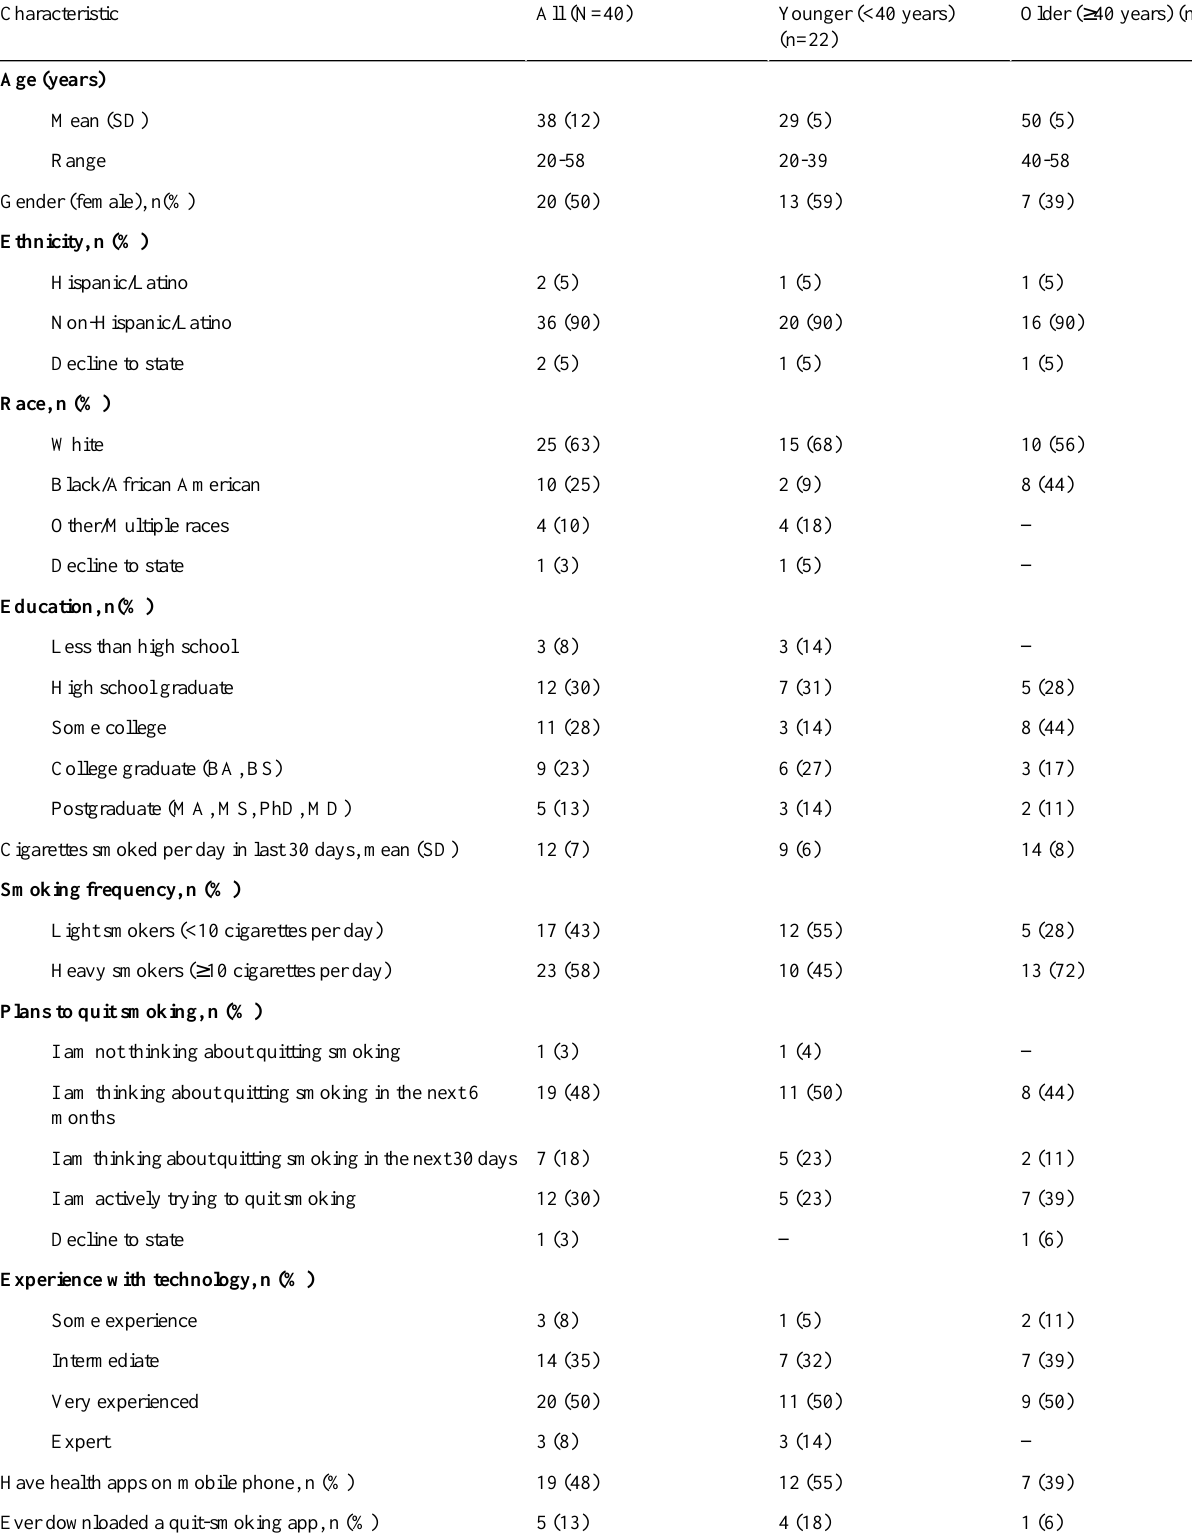
Table 1. Participant characteristics by age